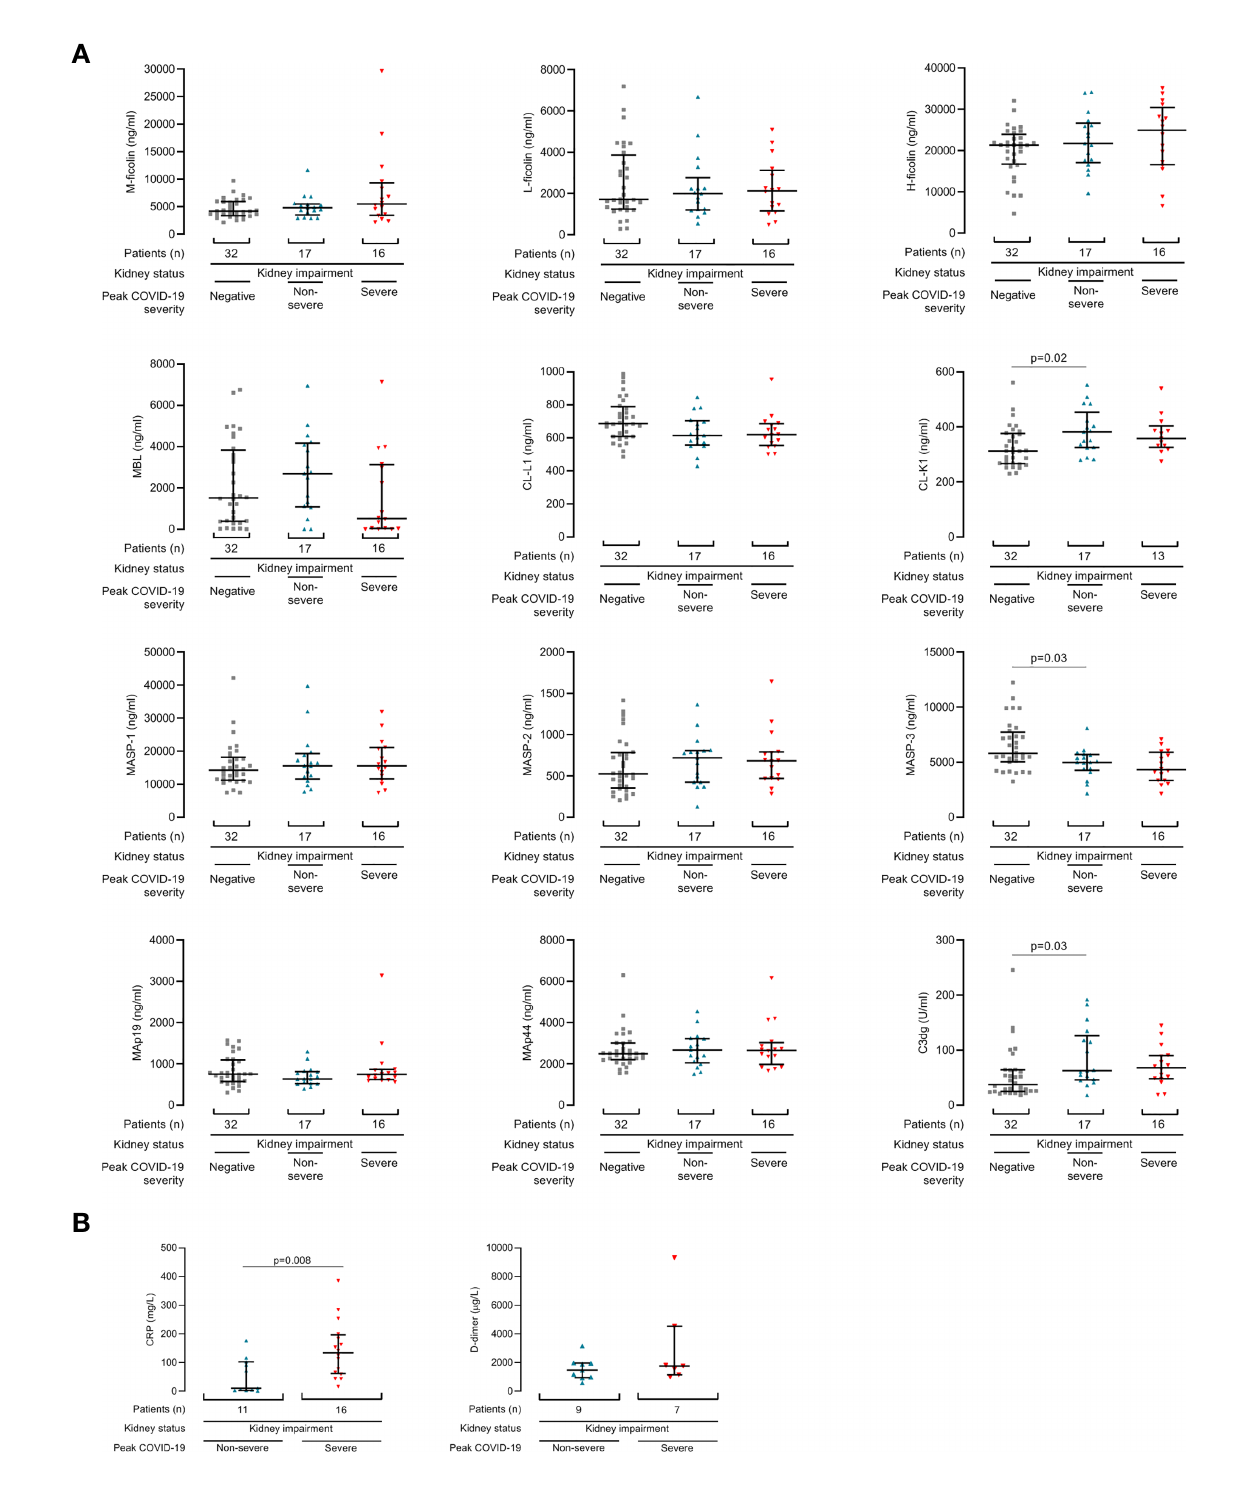
FIGURE 2 | Lectin pathway protein concentrations associate with COVID-19 from the fi rst samples after diagnosis. (A) Lectin protein levels from fi rst sample collected after COVID-19 diagnosis in 33 kidney disease patients, of whom 16 developed severe COVID-19 (red triangles) and 17 had non-severe disease (blue triangles). Controls are 32 haemodialysis patients without COVID-19 (grey squares). (B) CRP and d-dimer levels from fi rst sample collected after COVID-19 diagnosis in patients with kidney disease and COVID-19. Lines and whiskers show the median and interquartile values. Differences between cohorts were calculated with a Kruskall-Wallis test and follow-up comparison of the mean rank of every column. P values were adjusted for multiple comparisons as described in the